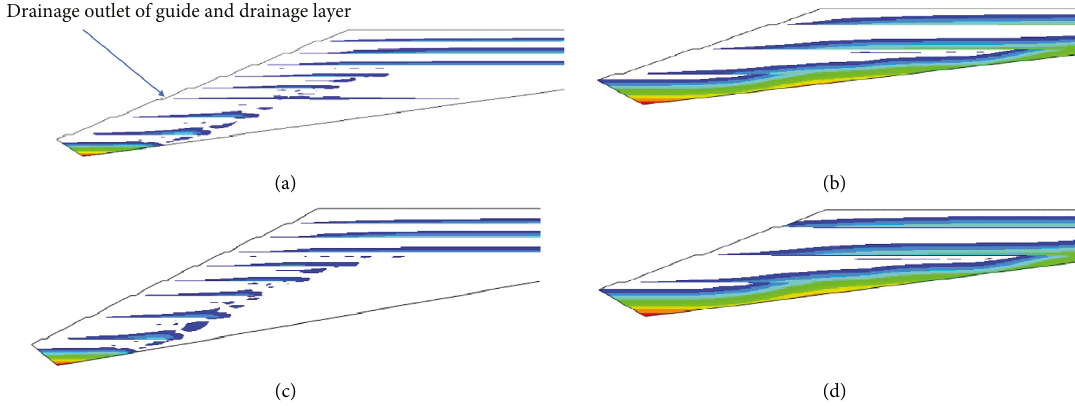
Figure 10: Leachate level distribution when the 4th layer of waste is completed. (a) Scheme 2. (b) Scheme 3. (c) Scheme 5. (d) Scheme 6.